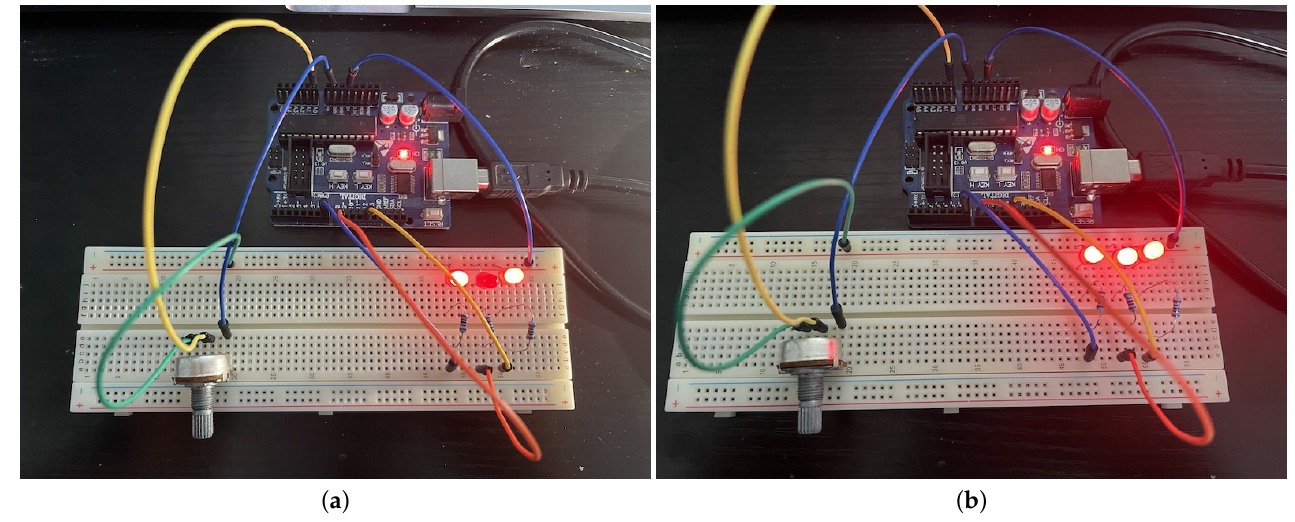
Figure 8. The Arduino Under Regular and Attack. ( a ) LED light 2 is Off (Without Attak). ( b ) The at- tack result of the malicious code (Under